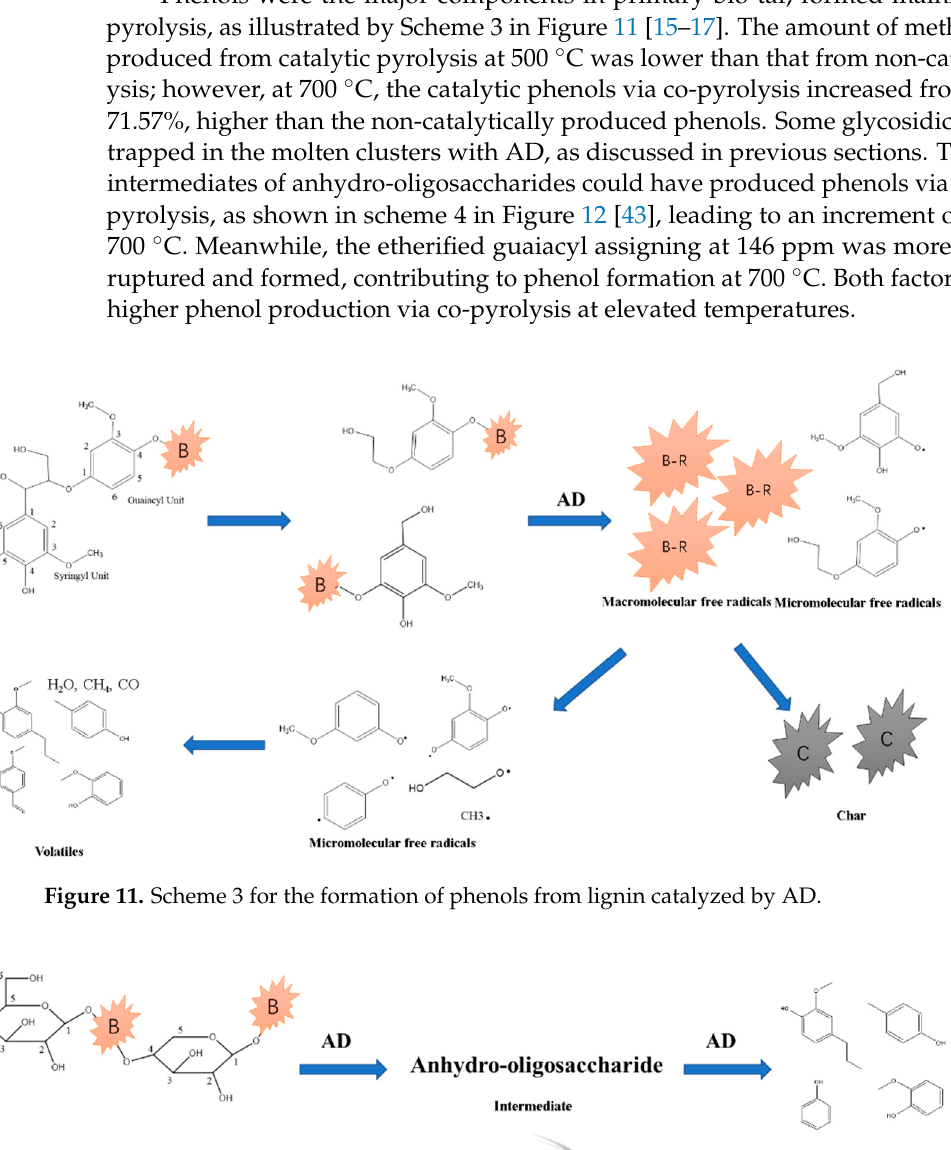
Figure 10. Scheme 2 for the formation of furans from cellulose and hemicellulose catalyzed by AD.